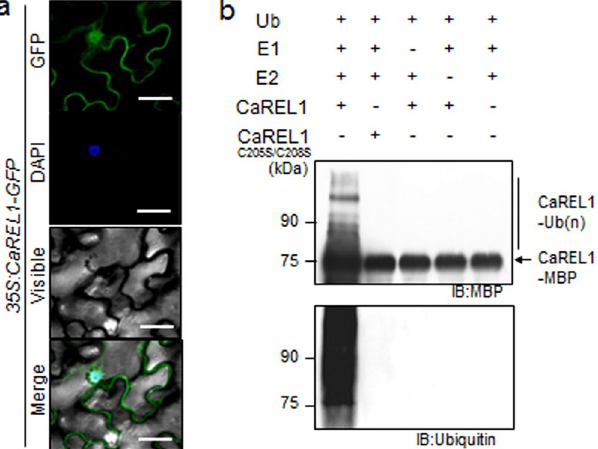
Figure 2. CaREL1 is localized at nucleus and has E3 ligase activity. ( a ) Subcellular localization of the 35S: CaREL1 -GFP fusion protein in Nicotiana benthamiana epidermal cells. The 35S: CaREL1 - GFP construct was expressed via agroinfiltration of N . benthamiana leaves and observed using a confocal laser-scanning microscope. DAPI staining was used as a marker for the nucleus. The scale bar represents 20 μ m. ( b ) Auto- ubiquitination of CaREL1. In the presence of ubiquitin, E1 (UbE1), and E2 (UBHPC H5b), maltose-binding protein (MBP)–CaREL1 fusion proteins displayed E3 ubiquitin ligase activity. Detection of MBP–CaREL1 auto- ubiquitination. MBP–CaREL1 C205S/C208S was loaded as negative control. MBP–CaREL1 fusion proteins were detected using MBP and ubiquitin antibodies; shifted bands indicate the attachment of ubiquitin